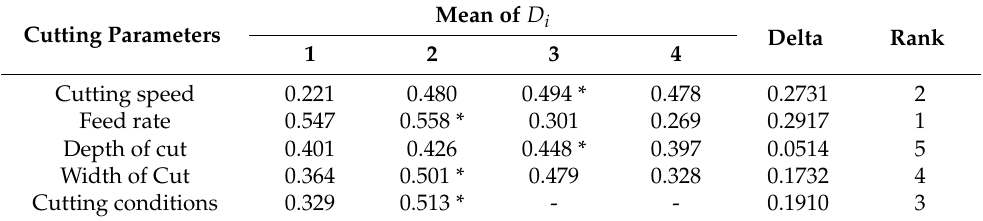
Table 11. Response table for